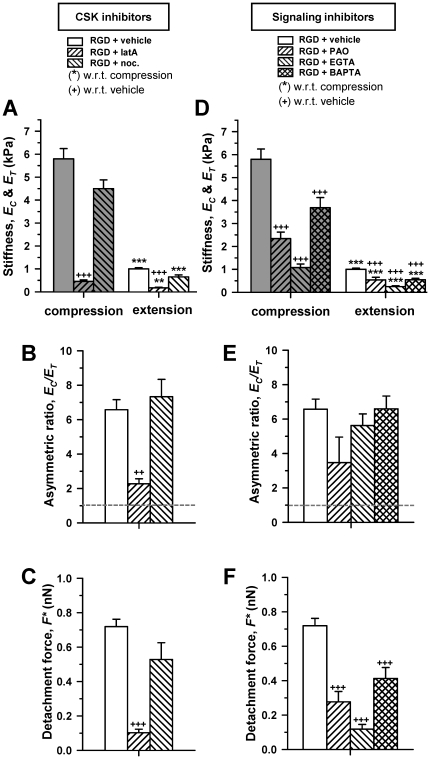
Role of cytoskeleton integrity, and Ca2+ and tyrosine phosphorylation-dependent signaling in lung cell mechanoresponses.(A–C) Effect of inhibitors against actin (latA) or microtubule (nocodazole) polymerization on (A) EC and ET, (B) EC/ET and (C) F* on CCD-19Lu fibroblasts probed with RGD-coated FE-AFM tips. (D-F) Effect of the tyrosine phosphatases inhibitor (PAO), and the extracellular (EGTA) and intracellular (BAPTA/AM) Ca2+ chelators on (D) EC and ET, (E) EC/ET and (F) F* probed in the same conditions as in (A–C). The legend of the bar filling patterns shown at the top of (A) and (D) apply to plots (A–C) and (D–F), respectively. Statistical analysis was performed as in Figure 3.